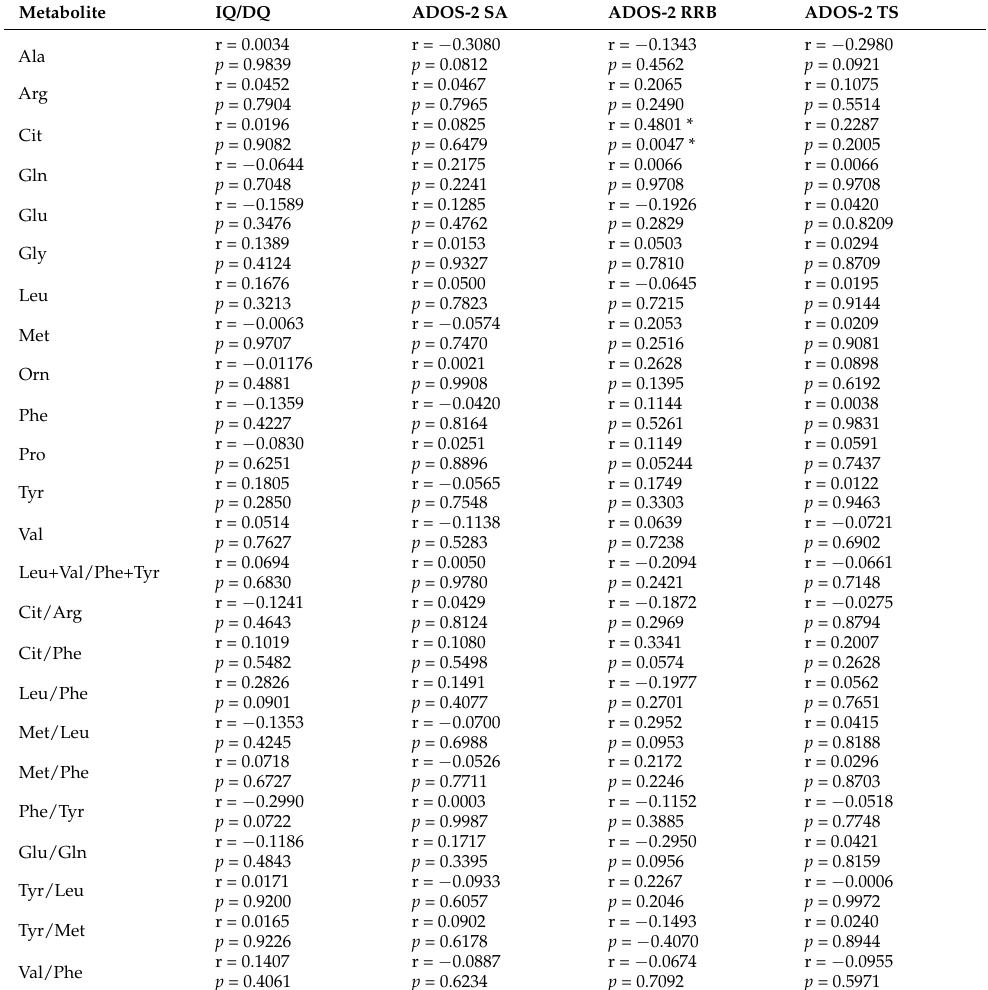
Table 4. Spearman correlation among metabolites and clinical features of ASD